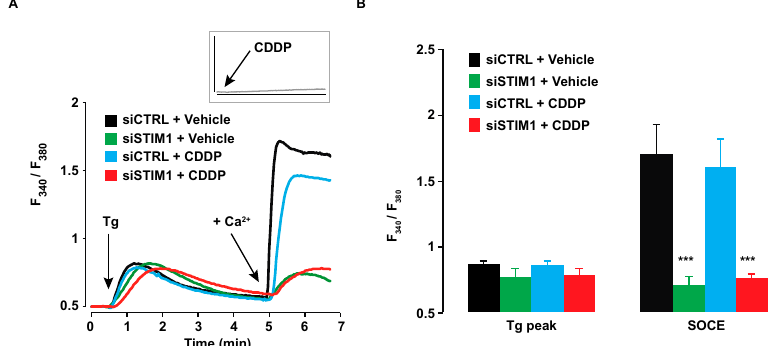
Figure 4. Influence of STIM1 depletion and CDDP on SOCE. ( A ) After transfection with siCTRL or siSTIM1, A549 cells were pretreated for 6 h with 25 µ M CDDP or the vehicle and then stained with Fura-2/AM to allow cytosolic Ca 2+ measurement. Tg was added in the absence of external Ca 2+ , in a solution of Krebs EGTA. The first Ca 2+ peak reflects the release of Ca 2+ from the ER. After ~4 min, Ca 2+ was added in the external medium, allowing SOCE. Traces are representative of at least 5 independent experiments (minimum 10 cells analysed per experiment). The acute effect of 25 µ M CDDP on cytosolic Ca 2+ is shown in the insert (same scale as the main graph). ( B ) Quantification of experiments presented in A. Results are expressed as means ± S.D. ( n ≥ 5). Student’s t test was employed to assess statistical significance. *** p <